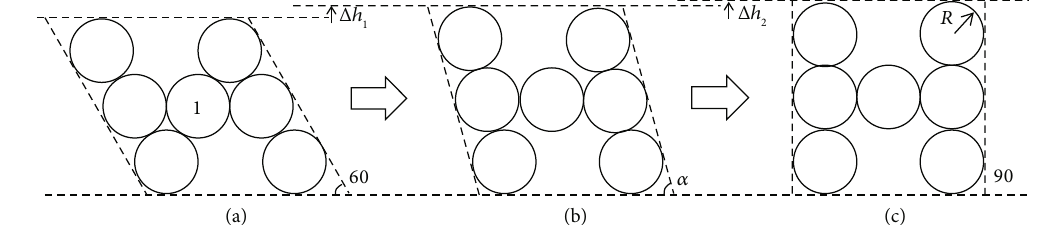
Figure 16: Shear dilation of the actual oil sand with insu ffi cient grain contacts.